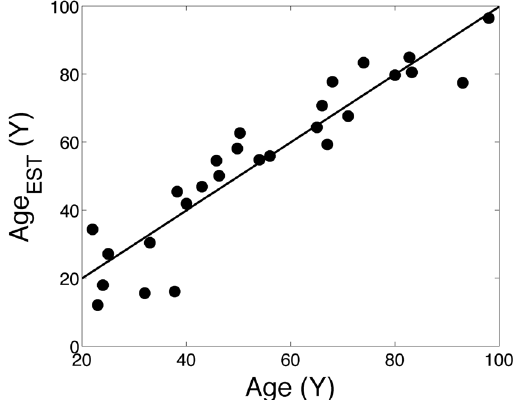
Figure 2. Plot of MZ couple age vs. age estimated by ridge regression with the optimal signature. The plot shows the estimation obtained for the validation set (i.e. all the twins from the 27 couples not used for signature